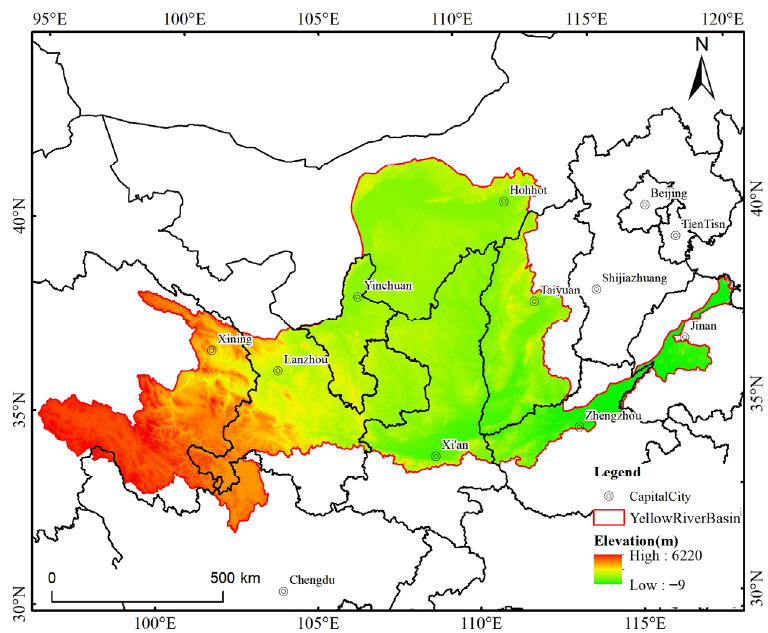
Figure 1. Location of the Yellow River basin (including digital elevation information of the Yellow River basin and provincial capital cities in the basin).